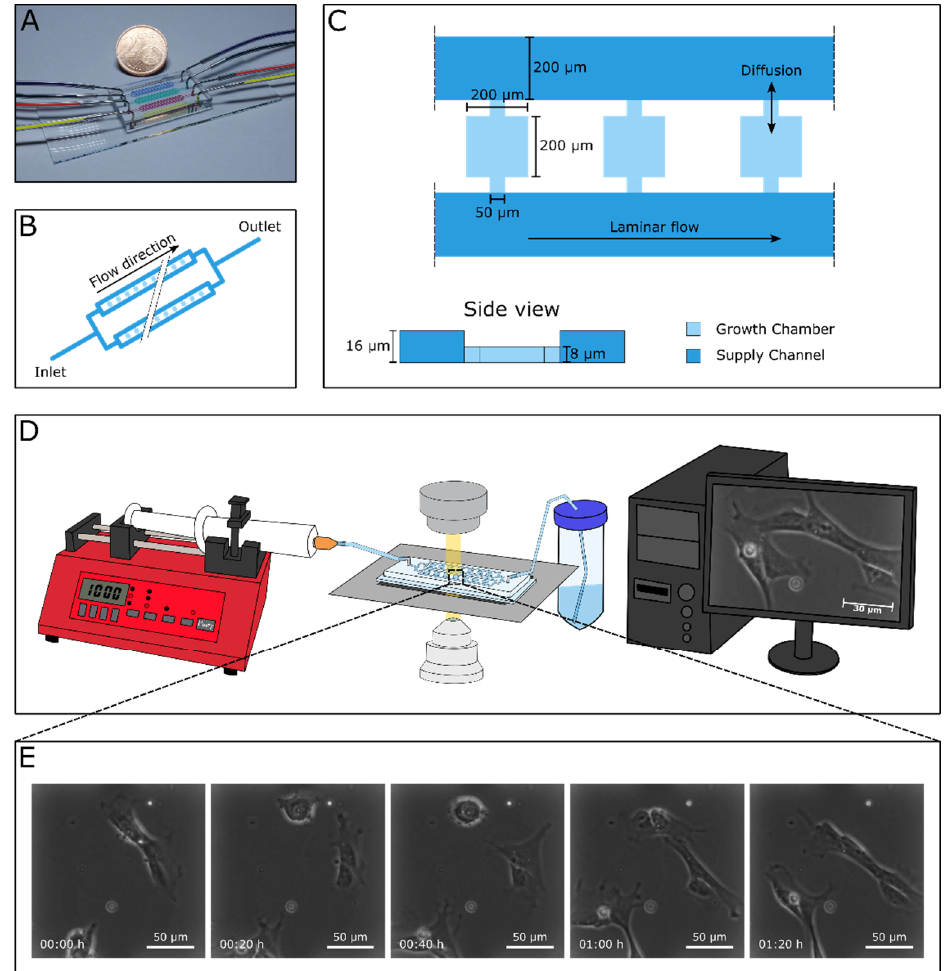
Figure 2. Chip design and working principle of the experimental setting. ( A ) Microfluidic cultivation device consisting of four cultivation arrays for the analysis of hCSCs. ( B ) Schematic figure of one cultivation array. Each array includes four parallel supply channels with 30 cultivation chambers between two of them, resulting in a total number of 60 chambers per array. ( C ) Three exemplary cultivation chambers with an area of 200 × 200 μ m 2 and a height of 8 μ m. The adjacent supply channels with a width of 200 μ m are twice as high. Mass transport from supply channel into the cultivation chambers is almost exclusively diffusive. ( D ) Experimental setup showing the syringe pump for steady medium supply, the microfluidic cultivation device mounted onto an inverted microscope, and the computer-assisted automated live cell imaging. ( E ) Time-lapse image sequence illustrating cellular behavior of single hCSCs.